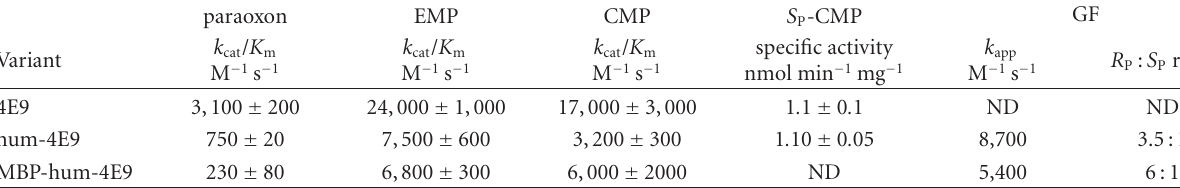
Table 2: Activity of hum-4E9. k cat / K m values were determined under constant 2% methanol conditions for all three substrates. None of the enzymes could be saturated with those substrates under experimental conditions. S P -CMP specific activities were determined at ∼ 0.0125 mM S P -CMP. GF k app hydrolysis rate constants and stereoisomeric preferences were determined using GF at 0.315 mM. ND: not determined.